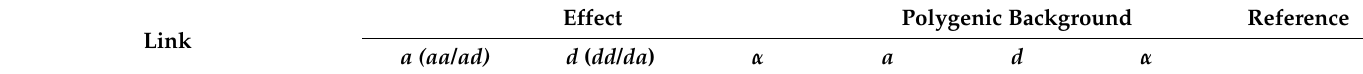
Table 6. LMM-based packages in